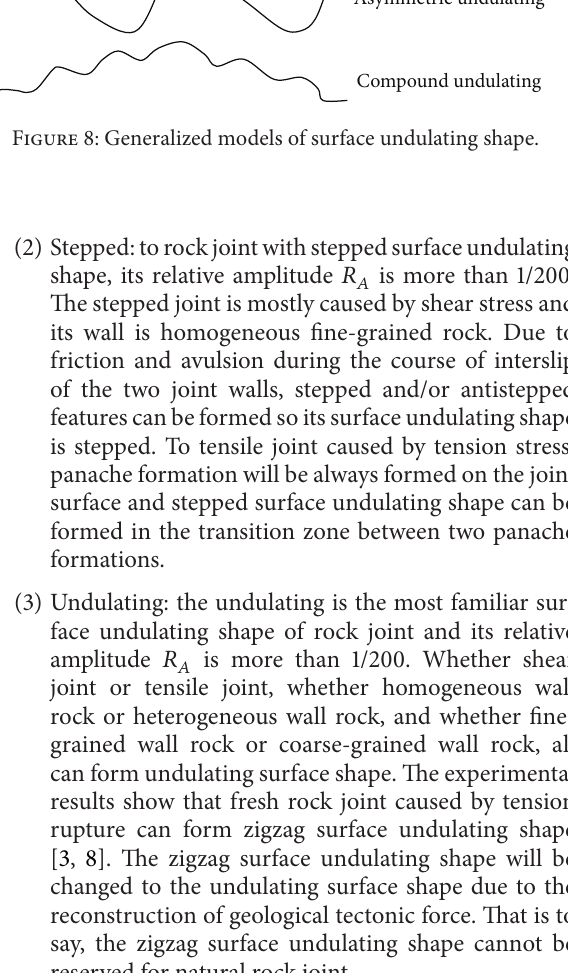
Figure 8: Generalized models of surface undulating shape.